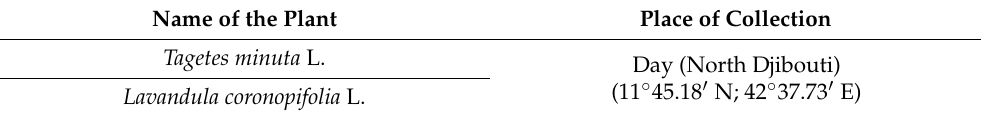
Table 1. Place of collection of the two aromatic and medicinal plants used. Name of the Plant Place of Collection Tagetes minuta